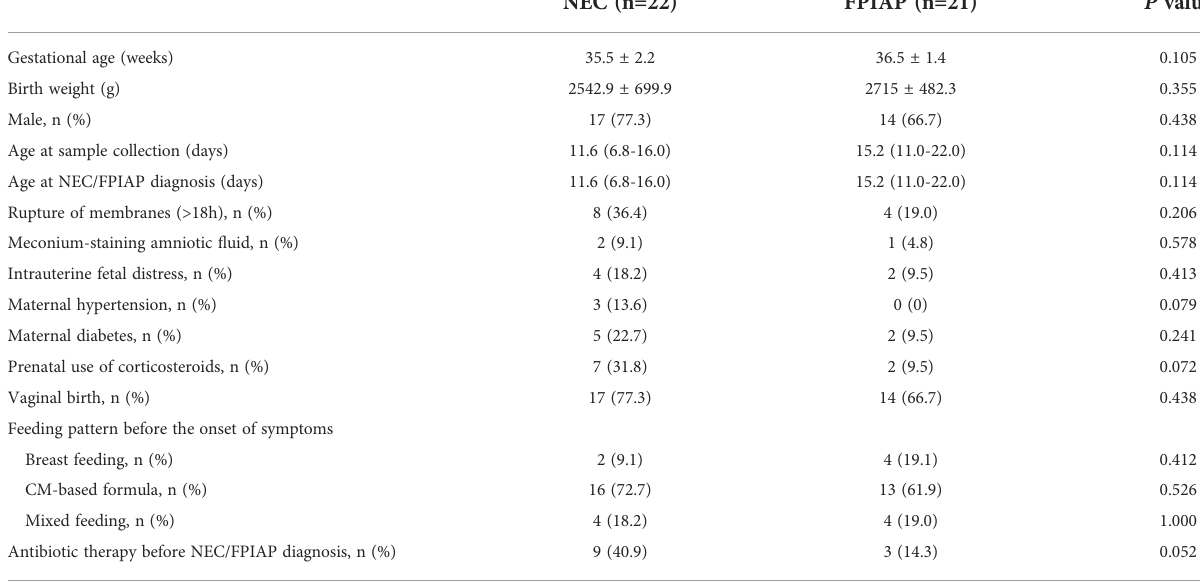
TABLE 1 Baseline characteristics of the newborns between the NEC and FPIAP groups.